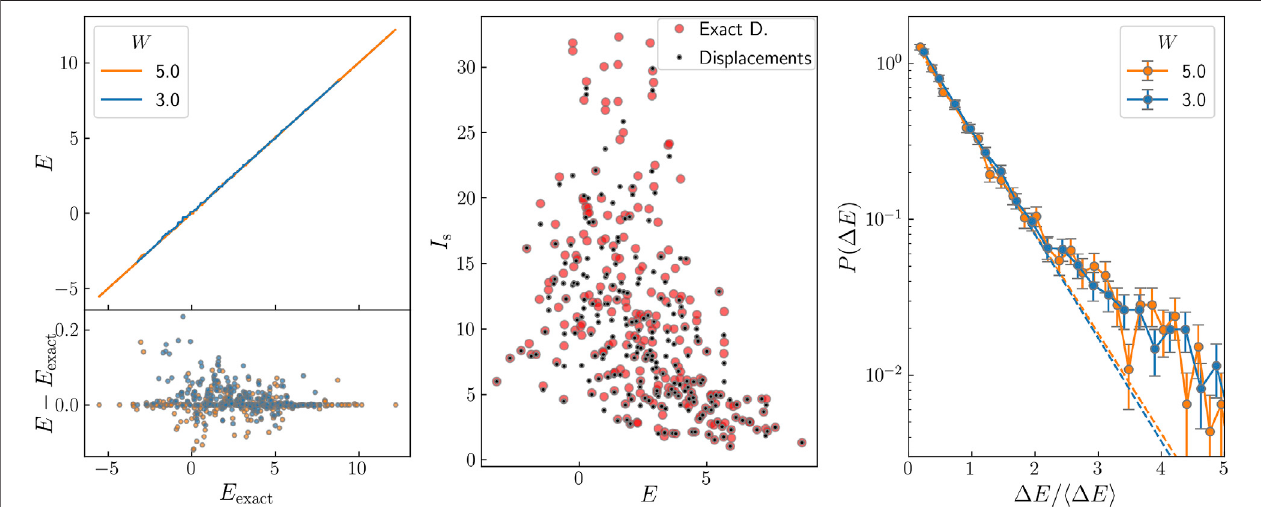
(cid:1) 10. Lower exact for two values of the disorder and L